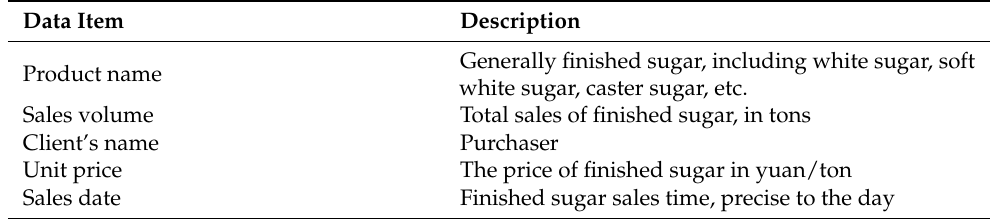
Table 3. Finished sugar sales data set